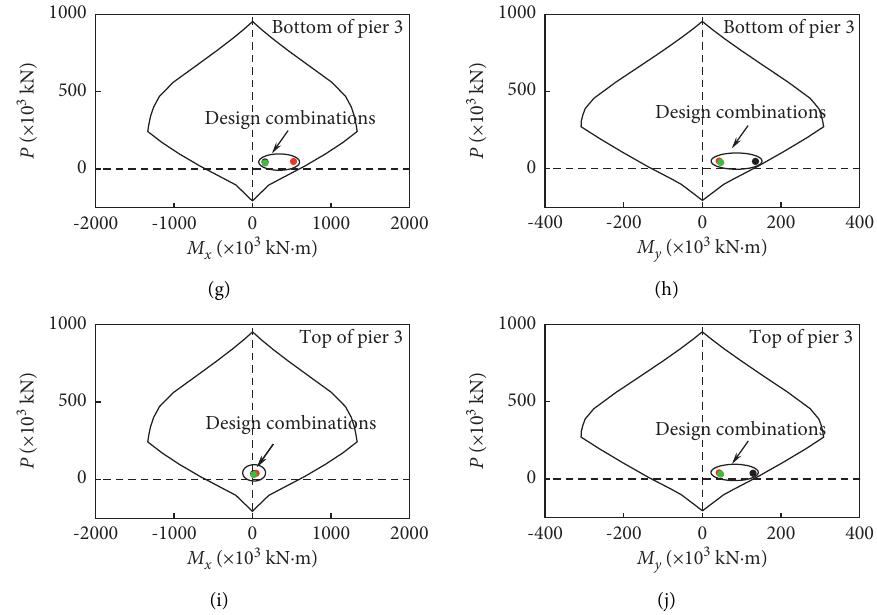
Figure 7: Moment-axial force interaction diagram for critical pier sections.